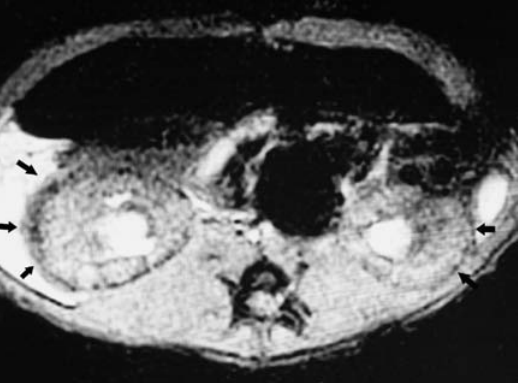
Figure 9 Signal intensity loss in the outer zone of the renal cortex (arrows) is detected on transverse T2*-weighted MR image of the kidney obtained 1 h after injection with the labelled mesenchymal stem cells (MSCs).